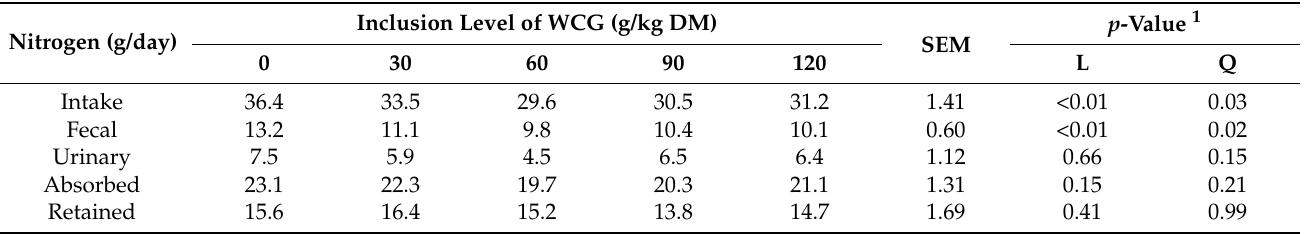
Table 2. Intake of nutritional components and fractions actually consumed by lambs fed diets containing whole corn